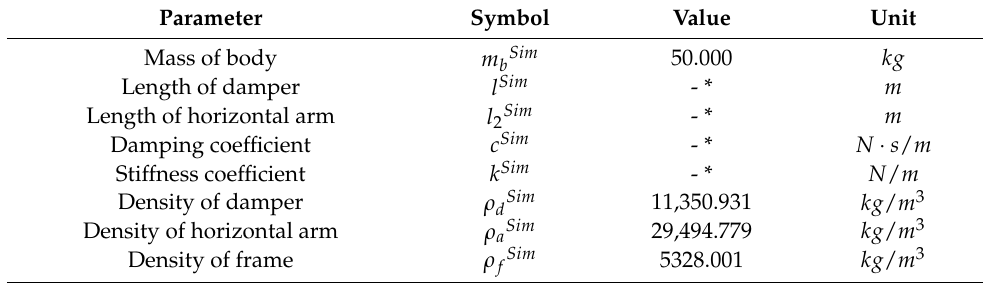
Table 7. Main parameters of the Adams parametric model for dynamics